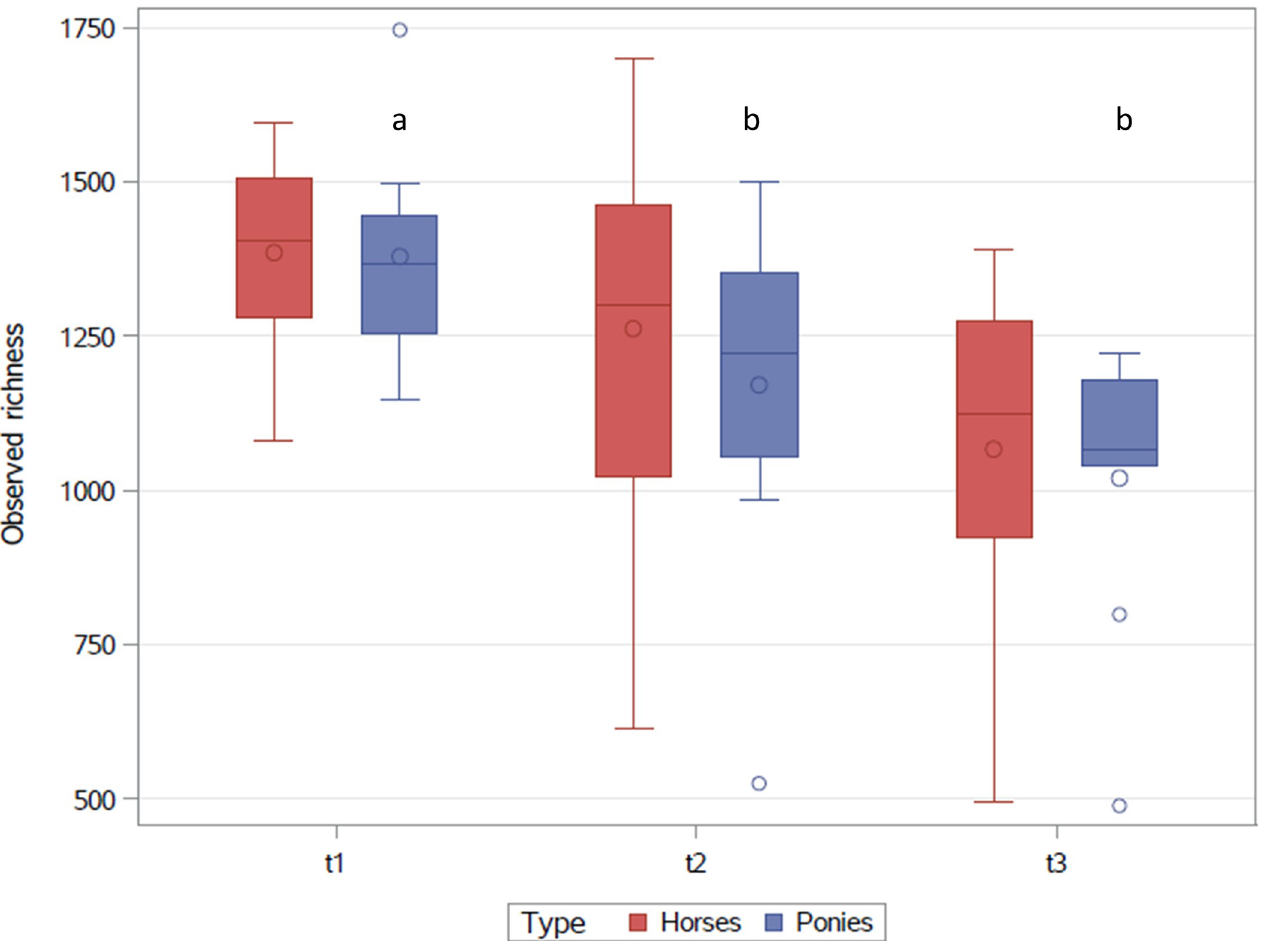
Fig 2. Observed richness at the three sampling points (t1-t3) for horses and ponies. The interquartile range is indicated by the box. The dot inside the box indicates the mean and the line the median. The whiskers represent the lower and upper extremes. Outliers are indicated as single dots.